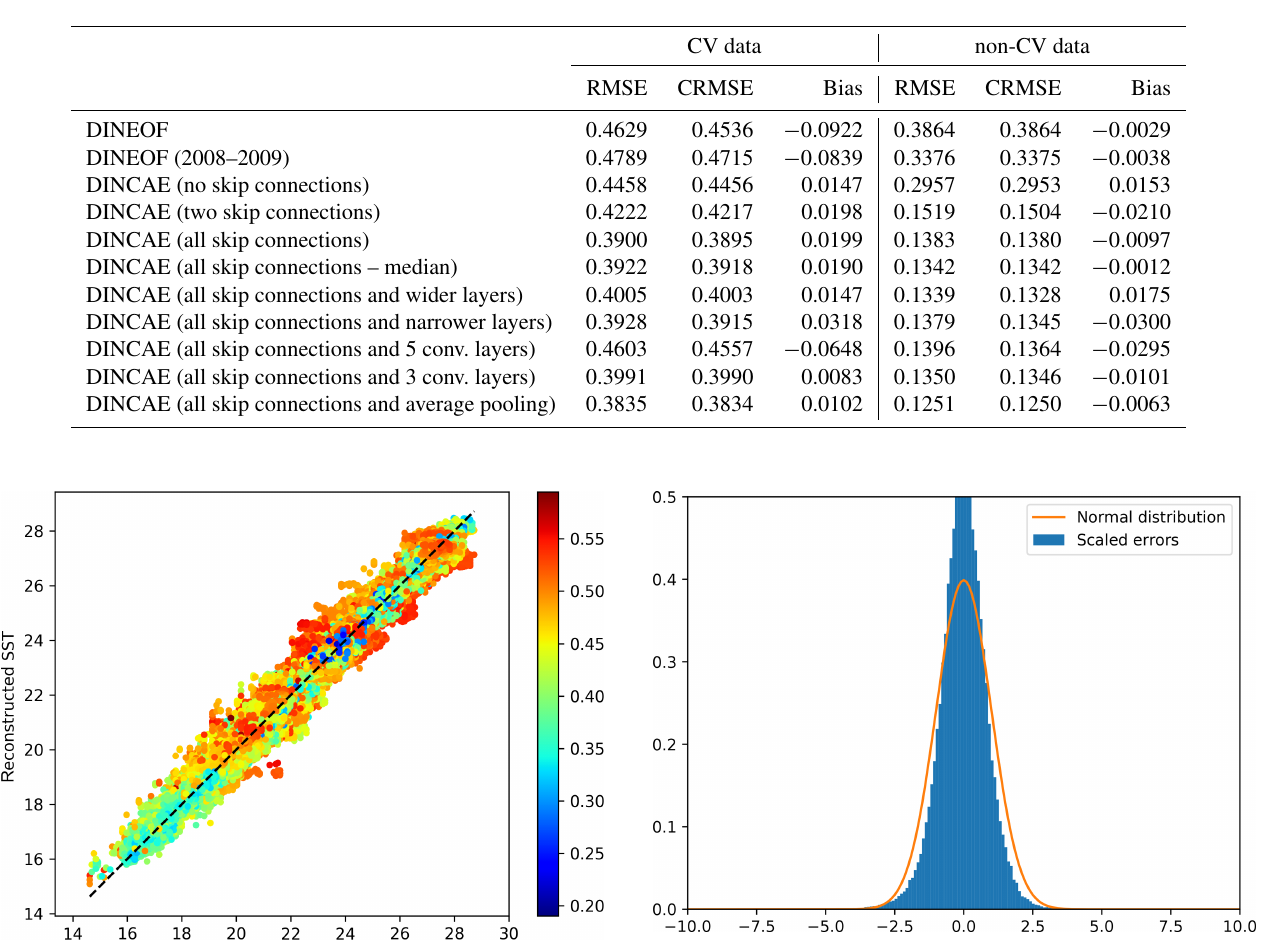
Table 2. Comparison with the independent cross-validation data and the dependent data used for training (in ◦ C). CRMSE is the centered root mean square error.